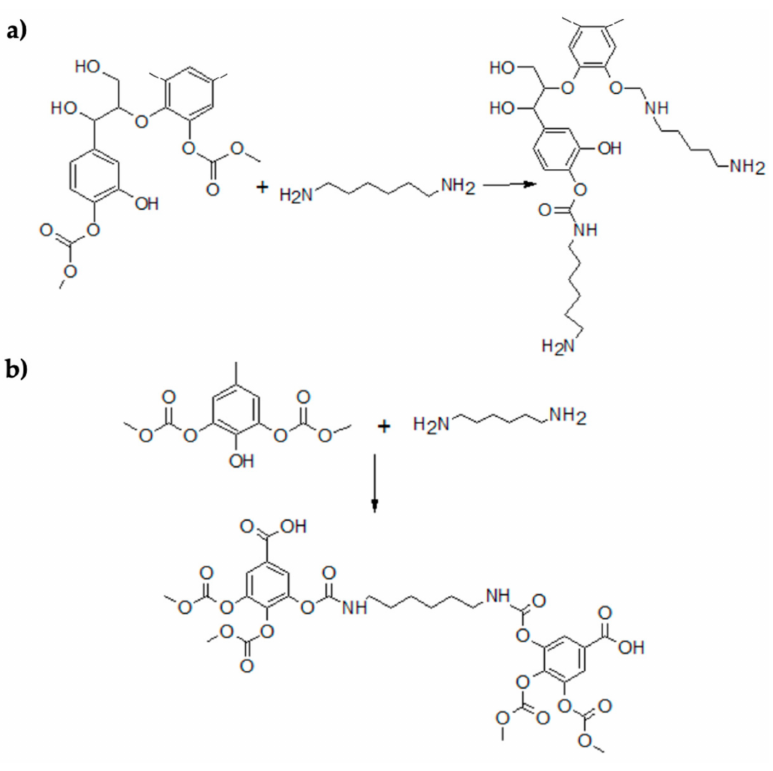
Figure 7. Scheme of non-isocyanate polyurethane obtaining from derivatives of lignin ( a ) and tannin ( b ).